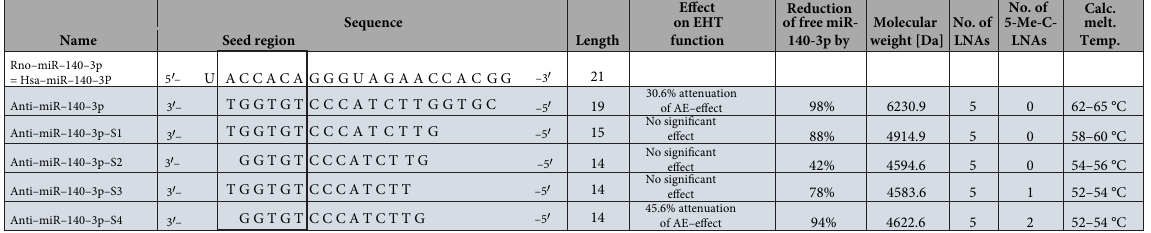
Table 2. Molecular and functional details of miR-140-3p